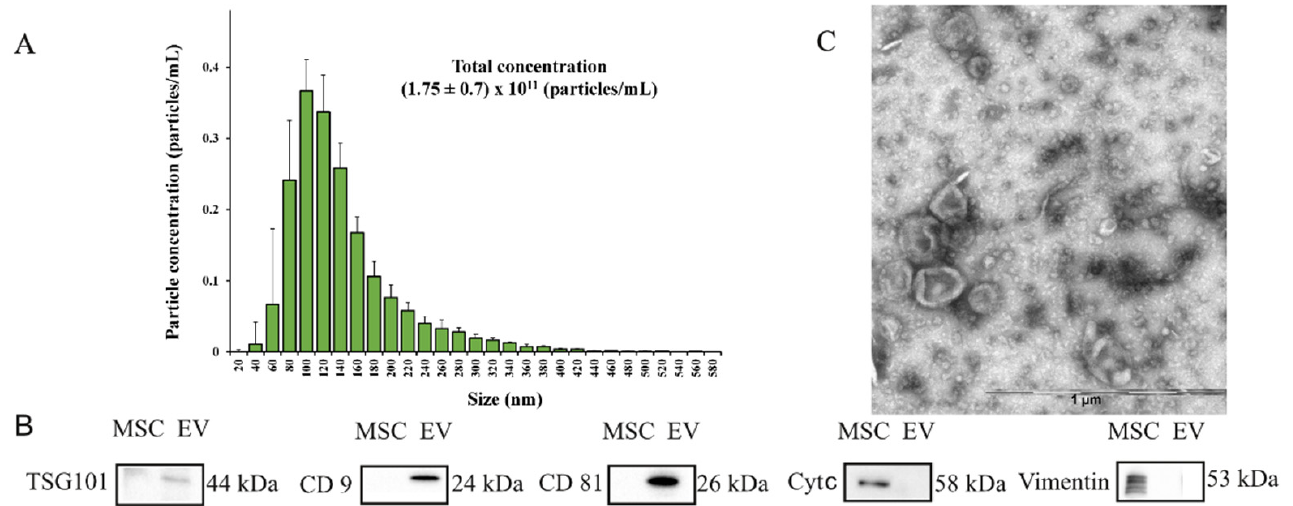
Figure 1. Characterization of EVs (produced by MSCs) in conditioned medium for 24 h of cultiva- tion. ( A ) Particle size distribution of EV samples, obtained by differential centrifugation with a mean diameter of 113 ± 32 nm. N = 5; SEM = 0.23 ( B ) Evaluation of EVs markers (CD9, CD81, and TSG101) and non-EV markers (vimentin and cytochrome c) by Western blot analysis. ( C ) Transmission elec- tron microscopy of EVs preparation.